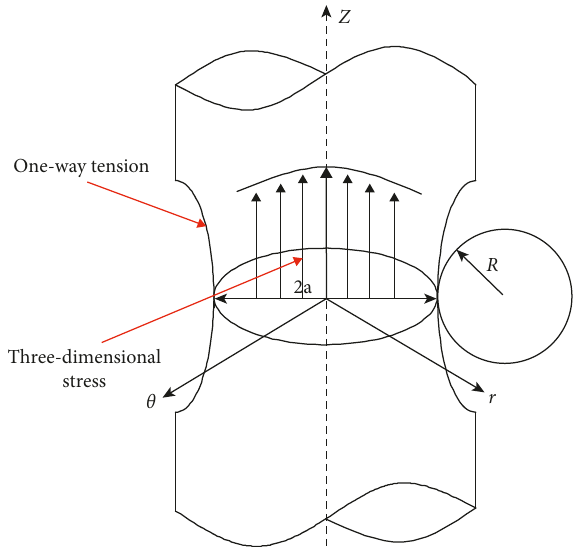
Figure 4: Three-dimensional stress of a part that undergoes necking during tensile